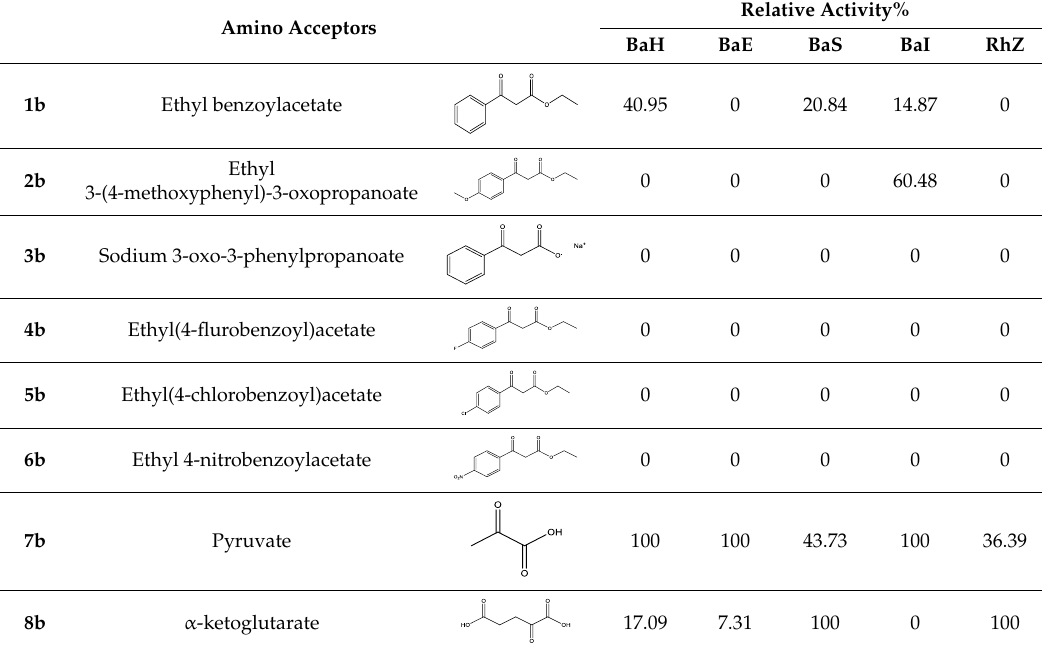
Table 3. Amino acceptor screened assays were carried out in Britton–Robinson bu ff er, pH 7